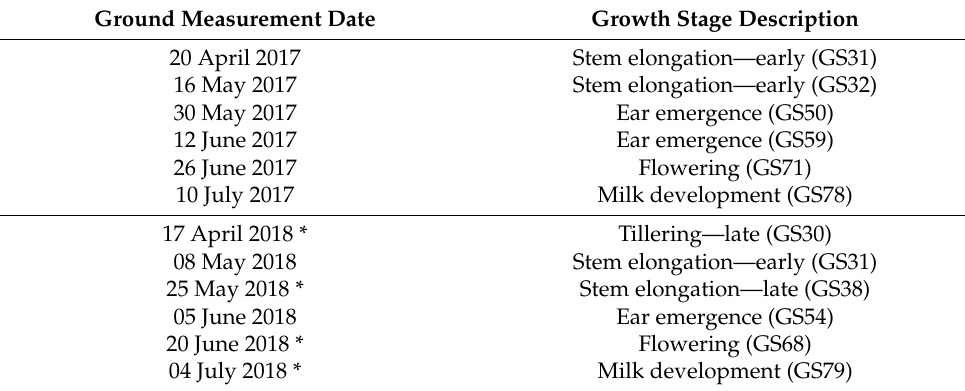
Table 1. Dates and corresponding average growth stages (GS; Zadoks et al. [38]) when non- destructive ground measurements were made at the winter wheat trial plots for two seasons: 2016– 2017 and 2017–2018. Note: asterisk (*) indicates additional destructive sample analysis